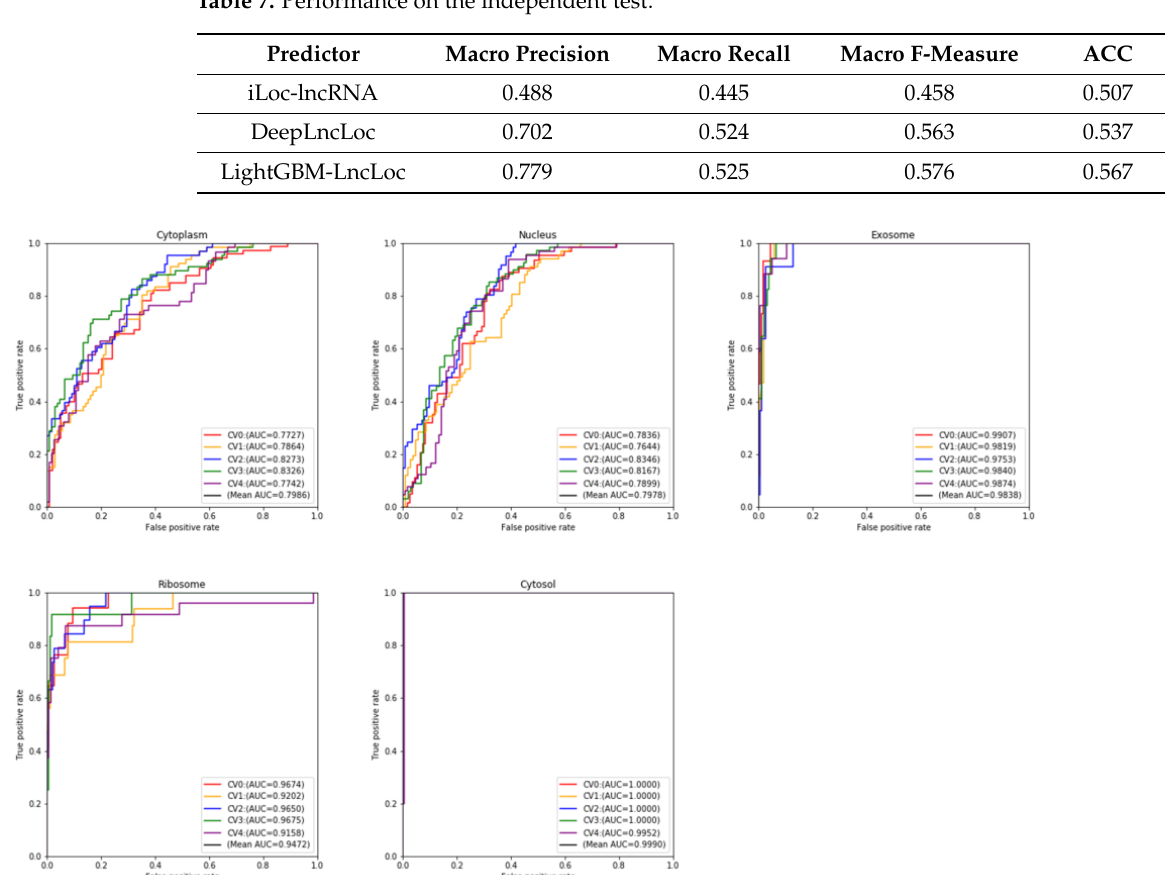
Table 7. Performance on the independent test.